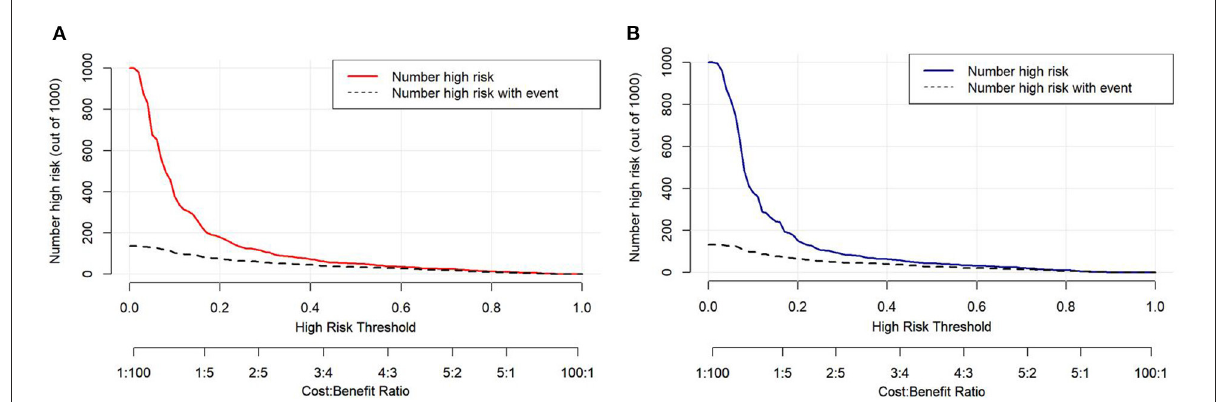
FIGURE6 The clinical impact curves of the risk prediction model in the development cohort (A) and validation cohort (B) . The number of high-risk patients and the number of high-risk patients with delayed extubation were plotted at different threshold probabilities within a given population.